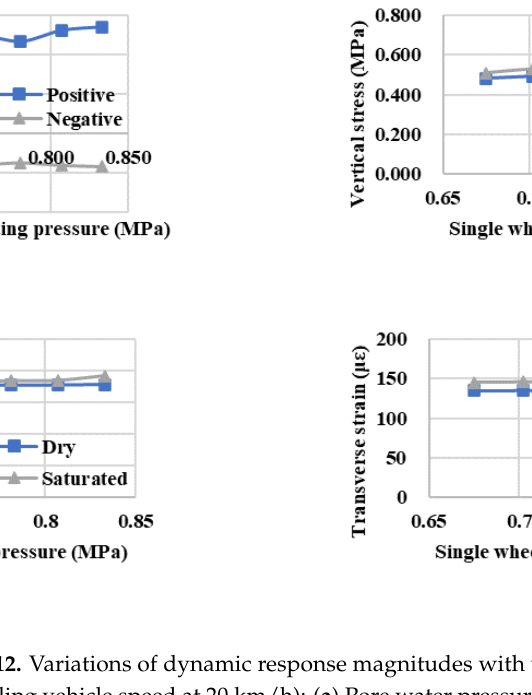
( d ) Figure 13. Variations of dynamic response magnitudes with vehicle speed obtained from field tests (controlling vehicle load at 0.7 MPa): ( a ) Pore water pressure; ( b ) Vertical stress; ( c ) Vertical strain; ( d ) Transverse strain. 4.4. Spatial Distribution of Dynamic Response Indicators by FEM Analysis 4.4.1. Vertical Distribution When vehicle load was applied to its maximum value of 0.7 MPa, vertical distribu- tions of dynamic response indicators along structural depths of asphalt pavement at three different vehicle speeds were analyzed for the testing profile A . Variation trends of dy- namic responses along structural depths with vehicle speeds in dry and saturated condi- tions are shown in Figure 14. It could be clearly found that vertical distributions of stress and strains in compressive regions inside dry asphalt pavement decreased with the in- crease in vehicle speed. However, vertical distributions of transverse strain increased with vehicle speed in tensile regions in dry conditions. Similarly, stress and strains exhibited similar variation trends in both compressive and tensile regions inside dry and saturated asphalt pavement, while vertical distributions of pore water pressure increased with the growth of vehicle speed. In Figure 14a, vertical distributions of stress in saturated conditions do not show ob- vious declining trends compared with those in dry conditions. Moreover, stress in the